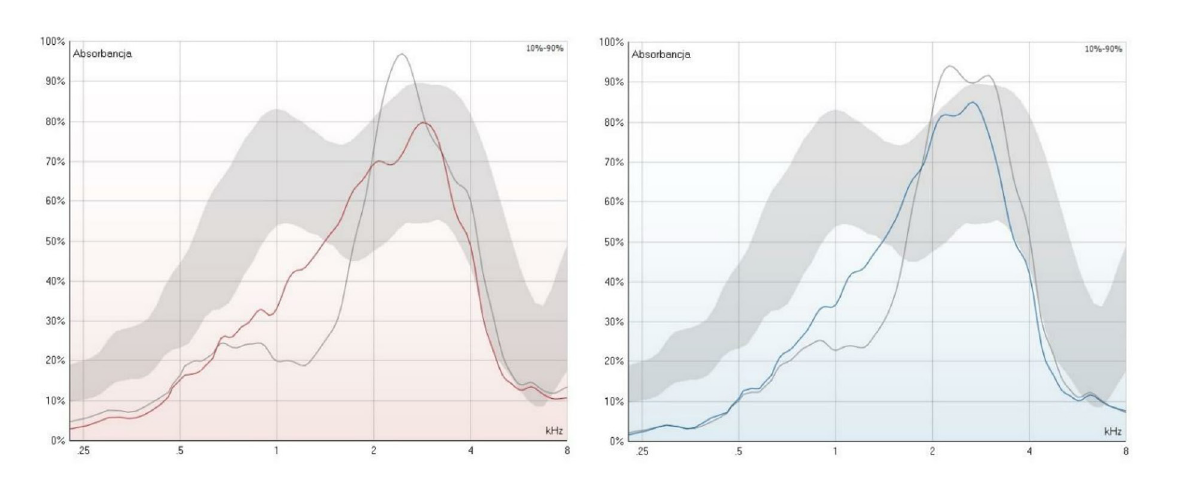
Figure 8. Results of absorbance measurement, right and left